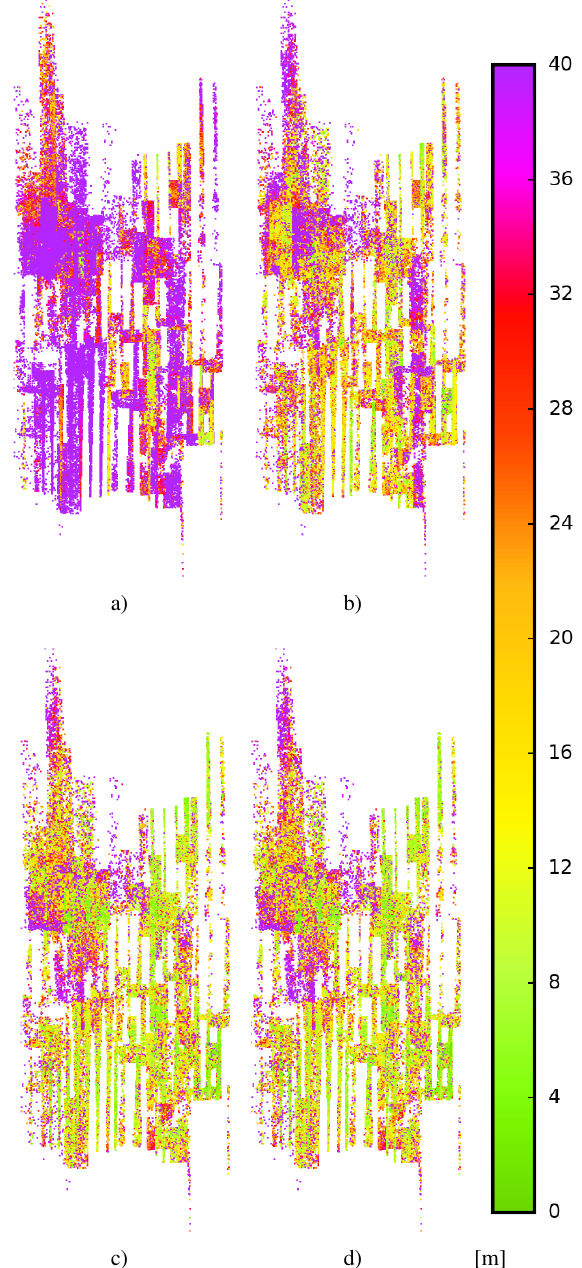
Figure 12: Color-coded intersection error of multi-strip points; a) before the adjustment, mean = 50.1m; b) after strip ad- justment, mean = 29.2; c) after block adjustment with unfiltered tie points, mean = 20.5m; d) after block ad- justment with filtered tie points, mean =